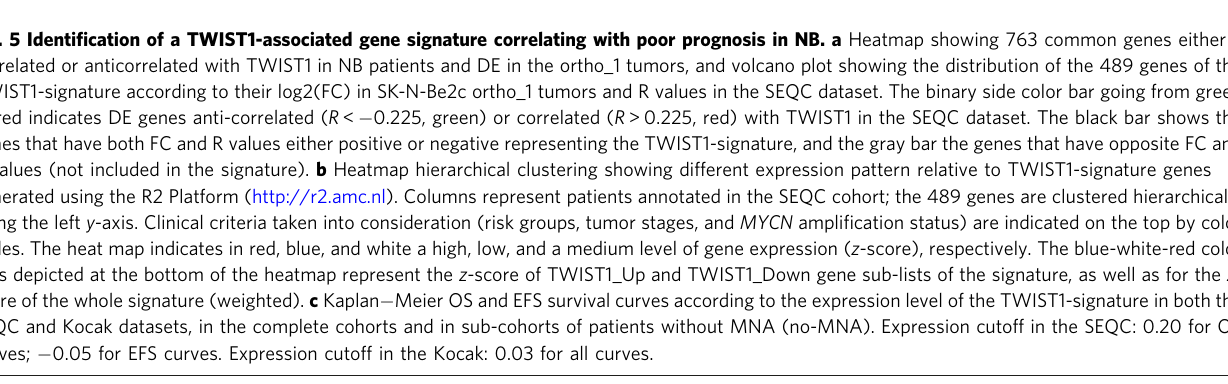
Fig. 5 Identi fi cation of a TWIST1-associated gene signature correlating with poor prognosis in NB. a Heatmap showing 763 common genes either correlated or anticorrelated with TWIST1 in NB patients and DE in the ortho_1 tumors, and volcano plot showing the distribution of the 489 genes of the TWIST1-signature according to their log2(FC) in SK-N-Be2c ortho_1 tumors and R values in the SEQC dataset. The binary side color bar going from green to red indicates DE genes anti-correlated ( R < − 0.225, green) or correlated ( R > 0.225, red) with TWIST1 in the SEQC dataset. The black bar shows the genes that have both FC and R values either positive or negative representing the TWIST1-signature, and the gray bar the genes that have opposite FC and R values (not included in the signature). b Heatmap hierarchical clustering showing different expression pattern relative to TWIST1-signature genes generated using the R2 Platform (http://r2.amc.nl). Columns represent patients annotated in the SEQC cohort; the 489 genes are clustered hierarchically along the left y -axis. Clinical criteria taken into consideration (risk groups, tumor stages, and MYCN ampli fi cation status) are indicated on the top by color codes. The heat map indicates in red, blue, and white a high, low, and a medium level of gene expression ( z -score), respectively. The blue-white-red color bars depicted at the bottom of the heatmap represent the z -score of TWIST1_Up and TWIST1_Down gene sub-lists of the signature, as well as for the z - score of the whole signature (weighted). c Kaplan − Meier OS and EFS survival curves according to the expression level of the TWIST1-signature in both the SEQC and Kocak datasets, in the complete cohorts and in sub-cohorts of patients without MNA (no-MNA). Expression cutoff in the SEQC: 0.20 for OS curves; − 0.05 for EFS curves. Expression cutoff in the Kocak: 0.03 for all